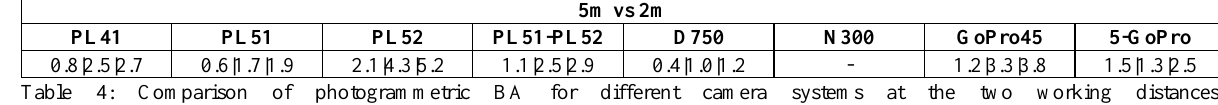
Table 4: Comparison of photogrammetric BA for different camera systems at the two working distances: RMSE XY |RMSE Z |3D_RMSE XYZ of differences computed on the nine coded targets 3D coordinates (values are in